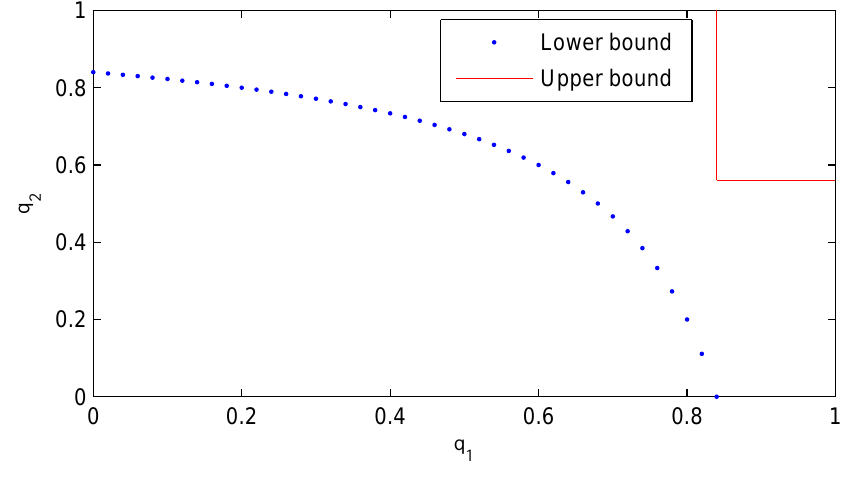
Figure 3. Stable and unstable